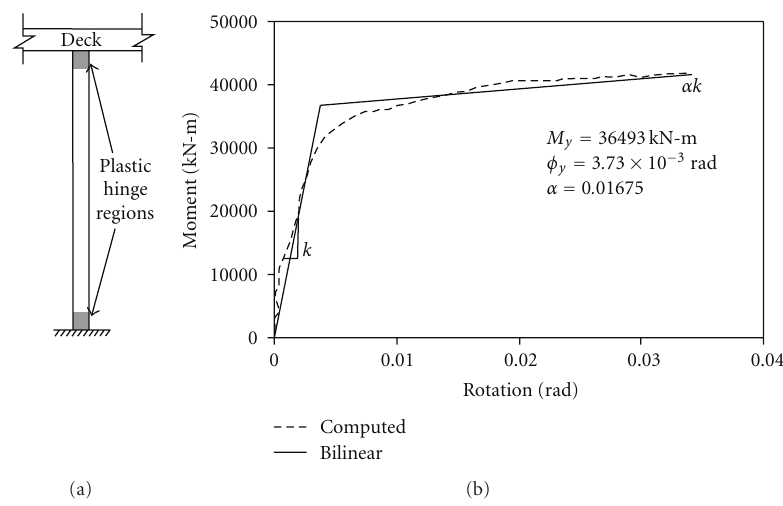
Figure 5: Locations of plastic hinges in the bridge pier and bilinear moment-rotation relationship.